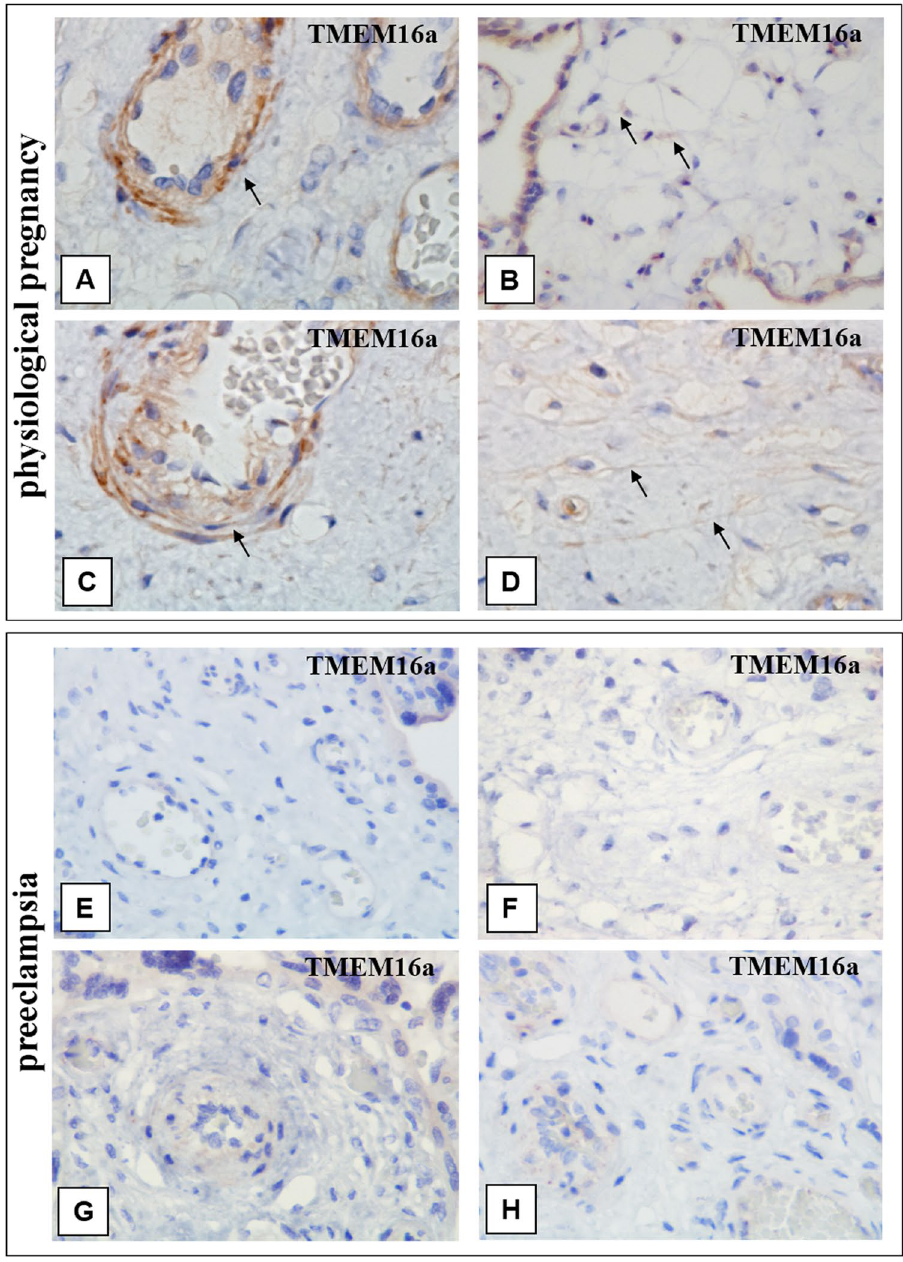
Figure 5. Immunohistochemical staining of placental villi with primary antibodies to TMEM16a in preeclampsia and physiological pregnancy. ( A–D ) Placental villous tree in a physiological pregnancy. ( A ) Weak staining of telocyte-like cells in the stem villi (at the 33th week). ( B ) Weak staining of telocytes in the stroma of immature intermediate villi. Telocytes delineate the vessel formation (at the 27 th week) (indicated with arrows). ( A ) x600. ( B ) x600. ( C and D ) Staining of ( C ) myofibroblasts in the vascular wall (at the 39 th week) and in ( D ) the stem villi stroma (telocytes and telopodes are indicated with arrows). ( С and D ) х600. ( E and F ) Villous trees in early-onset PE (at the 32th week). Staining of the stroma in the ( E ) intermediate villus and ( F ) stem villus is not shown. E and F. x600. G and H– Villous trees in late-onset PE (at the 38 th week). There is no staining of telocytes and myofibroblasts in the ( G ) intermediate villus and ( H ) stem villus. G and H.